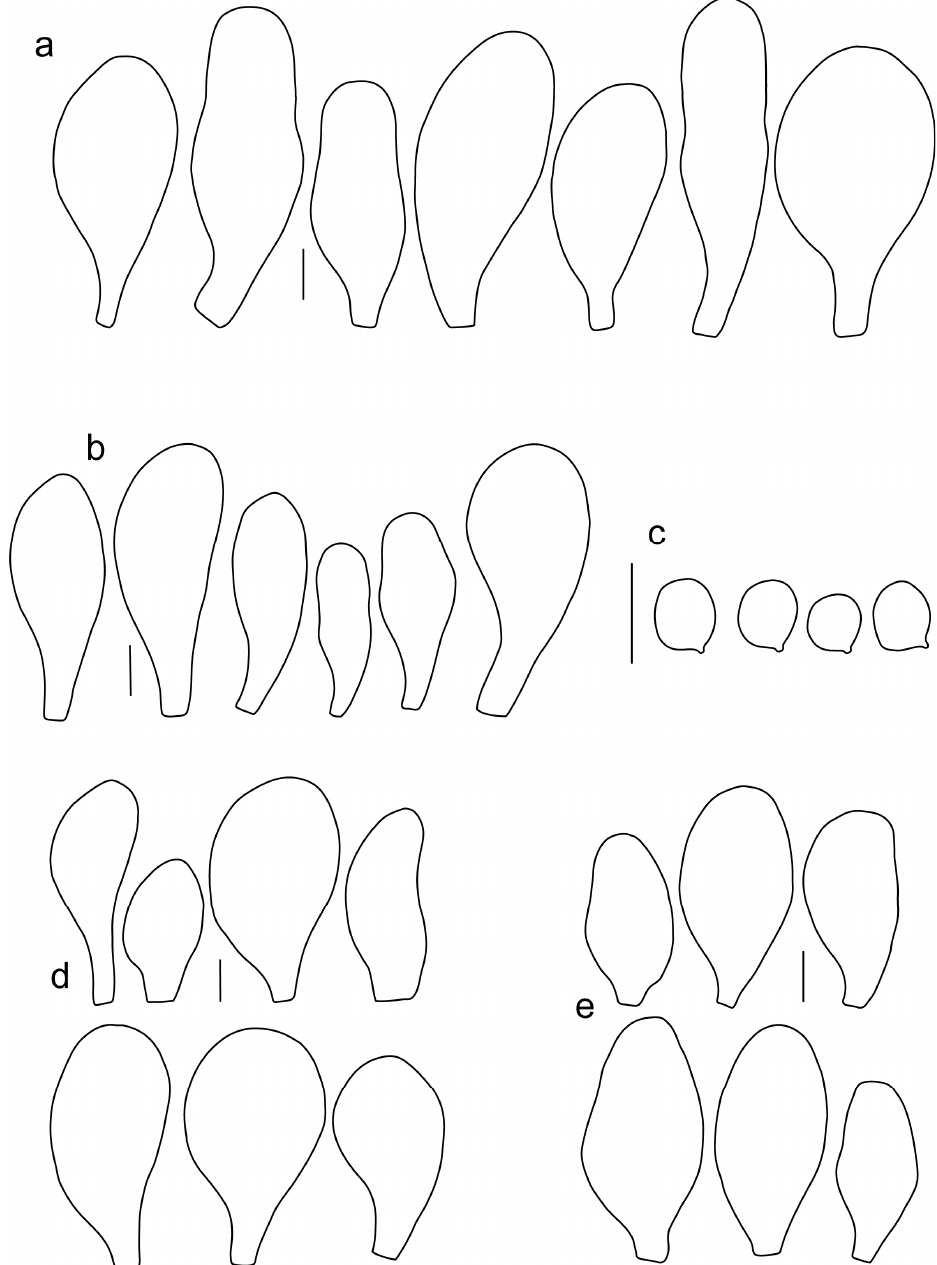
Figure 9. Pluteus fulvibadius : ( a ). pleurocystidia, ( b ). cheilocystidia ( c ). basidiospores, ( d ). pileipellis elements, ( e ). caulocystidia. Scale bars 10 µm.